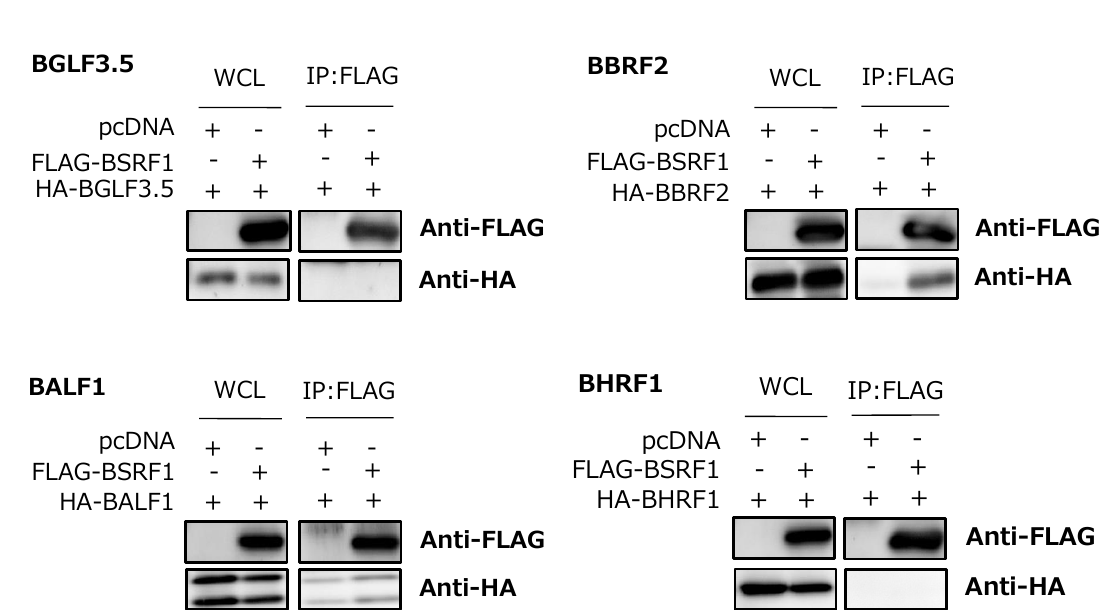
Figure 6. Association of BSRF1 with other viral proteins. ( A ) HEK293T cells were cotransfected by lipofection with the indicated expression vectors. After 24 h, whole-cell lysates were prepared and a portion was subjected to immunoblotting using anti-FLAG and -HA antibodies. The remaining lysates were subjected to immunoprecipitation (IP) using an anti-FLAG antibody, followed by immunoblotting with anti-FLAG and -HA antibodies. ( B ) The lysates were immunoprecipitated with an anti-HA antibody, followed by immunoblotting. ( C ) HEK293 EBV-BAC (wild-type) cells were transfected by lipofection with the indicated vectors, and subjected to IP using an anti-FLAG antibody followed by